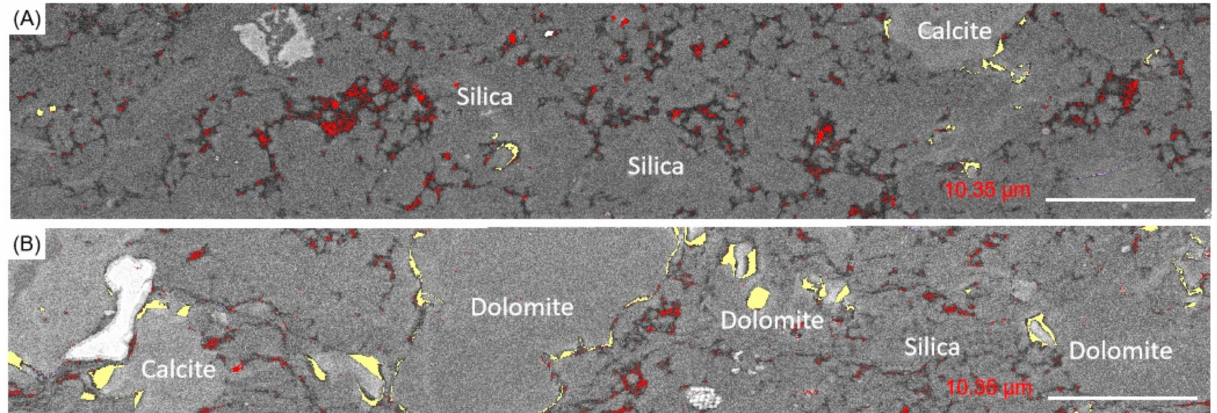
Figure 12. Backscattered electron images showing nanopores and microfractures in clayey laminae and silty laminae. ( A ) In clayey laminae, organic pores are rich and propagate along organic matters to form dense networks; ( B ) In silty laminae, inorganic pores are abundant but commonly occur isolated. Note that the red color denotes organic pores, the yellow color represents inorganic pores and the lilac color represents